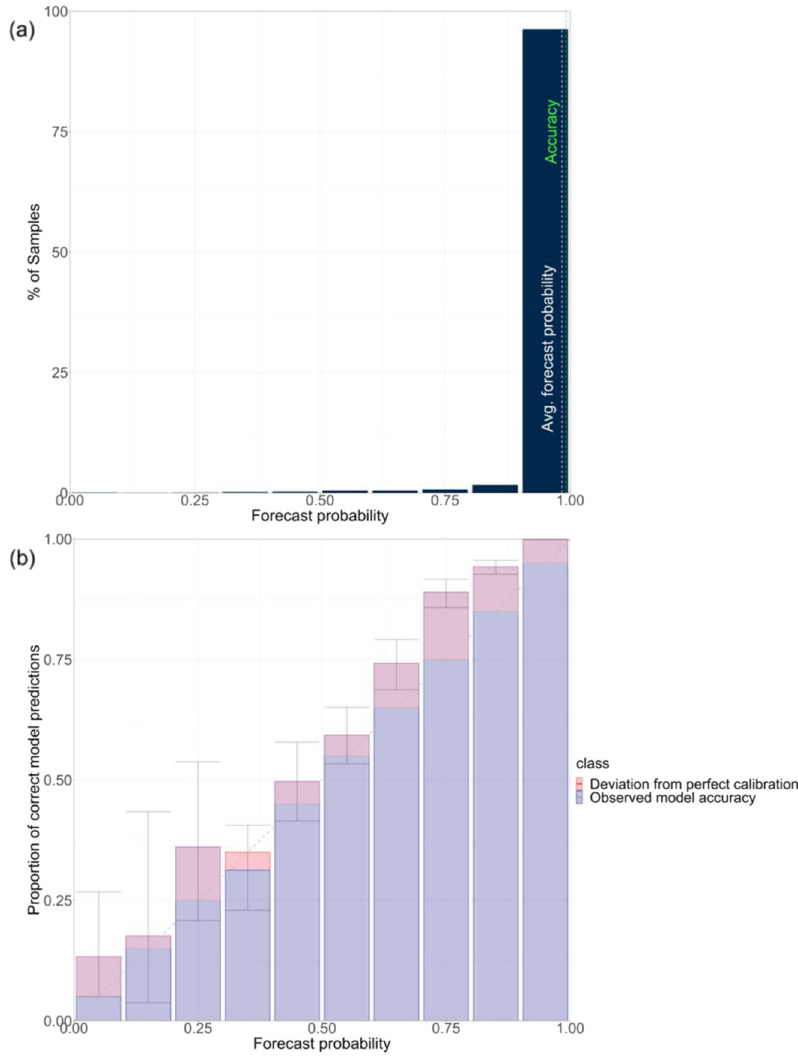
Fig. 2 Con fi dence histogram and reliability diagram for the National Drug Code prediction model on the test dataset. a The con fi dence histogram shows the percentage of samples falling into each forecasted probability bin, while ( b ) the reliability diagram plots the observed predicted probability accuracy against the expected probability, where the range of forecasted probabilities is divided into ten bins (i.e., 0 – 0.1, 0.1 – 0.2, 0.2 – 0.3, etc.). Error bars in the reliability diagram represent 95% con fi dence intervals for each bin and the numbers of images in each bin are 45, 17, 36, 115, 153, 285, 287, 471, 1063, 62,802,